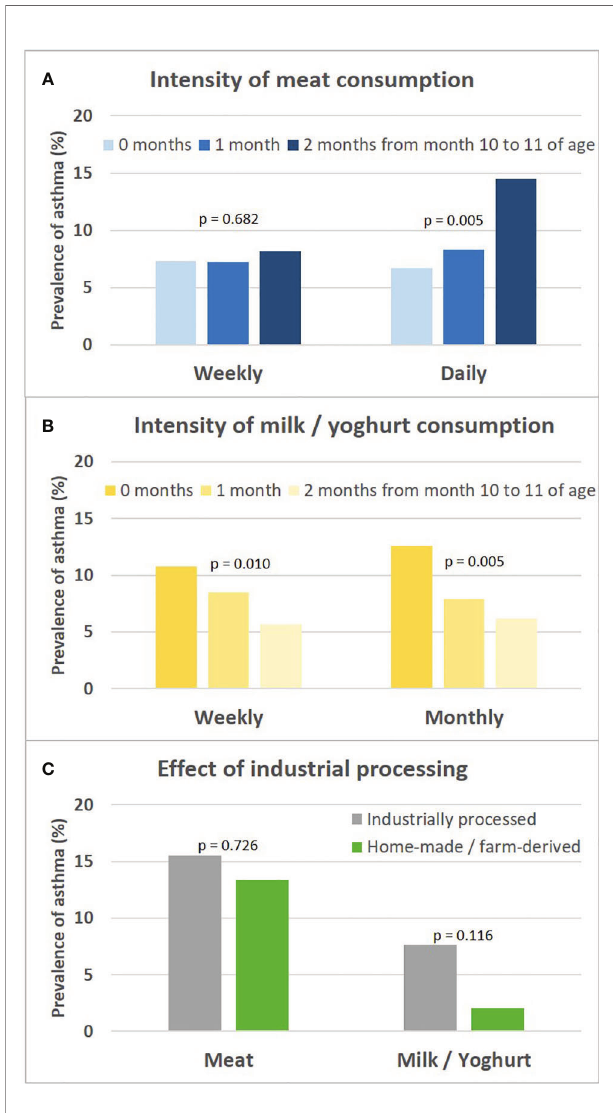
FIGURE 11 | Sensitivity analyses on intensity of meat and milk or yoghurt consumption and the role of industrial processing. Shown is the prevalence of asthma in relation to the intensity of meat and milk/yoghurt consumption during month 10 and 11 ( A, B , respectively). (C) presents prevalence of asthma in relation to industrial food processing; for meat, excessive consumption (daily over both months 10 and 11) and for milk, moderate consumption (weekly either during month 10 or 11) is displayed. For bivariate comparisons, we used the Chi-square or Fisher ’ s exact test, for trends we used the Cochran-Armitage trend